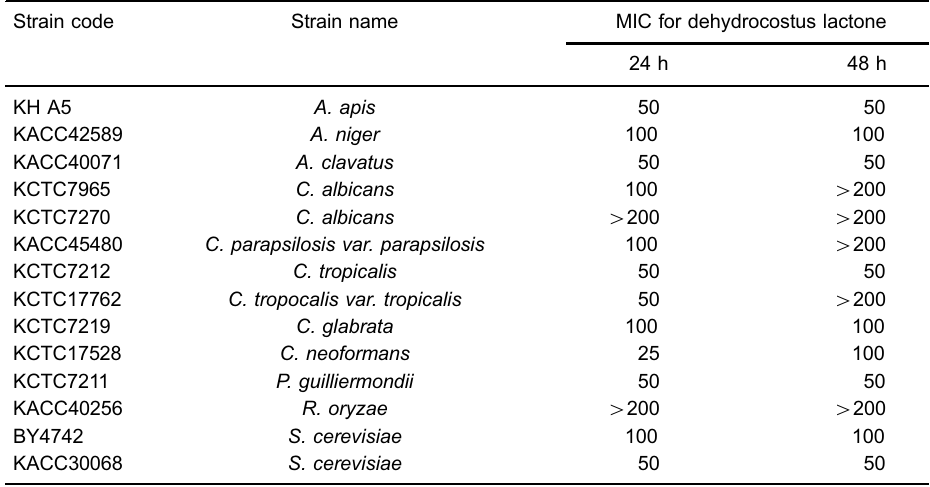
Table 4 . In vitro susceptibility of fungi to dehydrocostus lactone at 24 and 48 h. Strain code